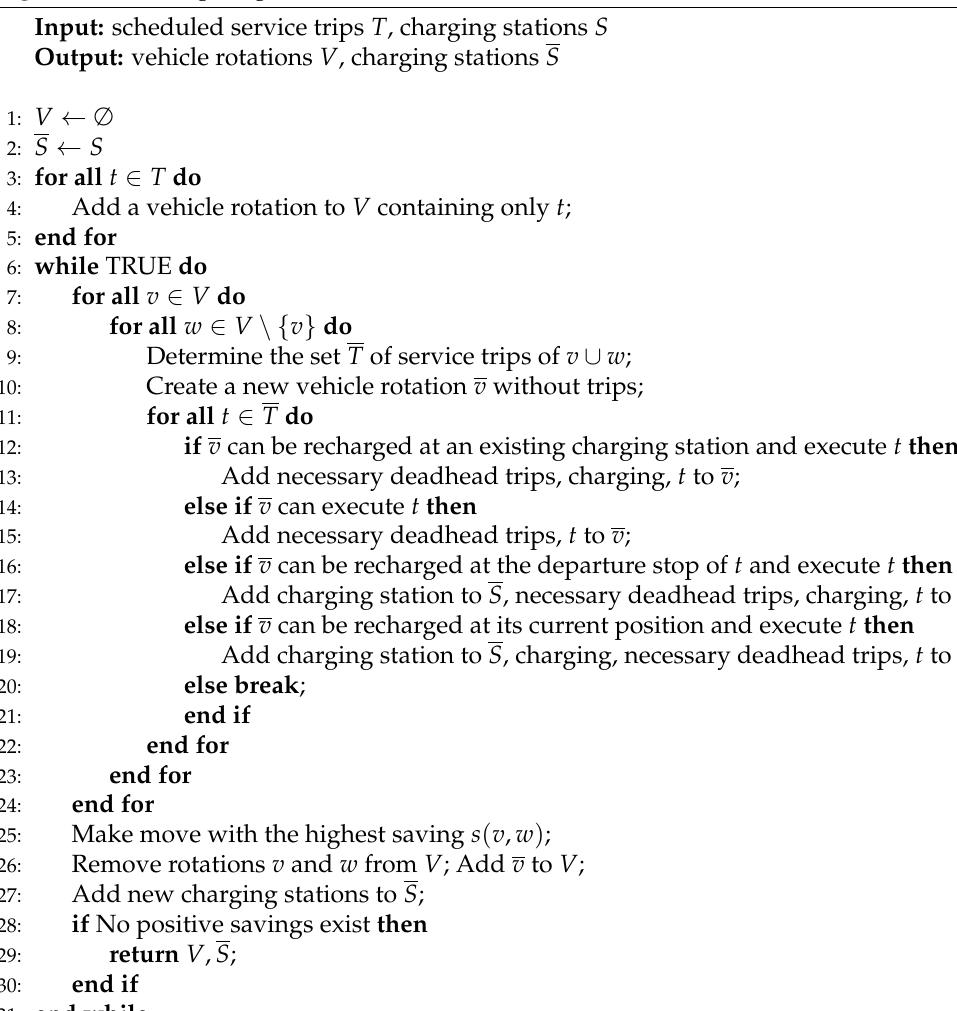
Algorithm 2 Savings Algorithm ( SA